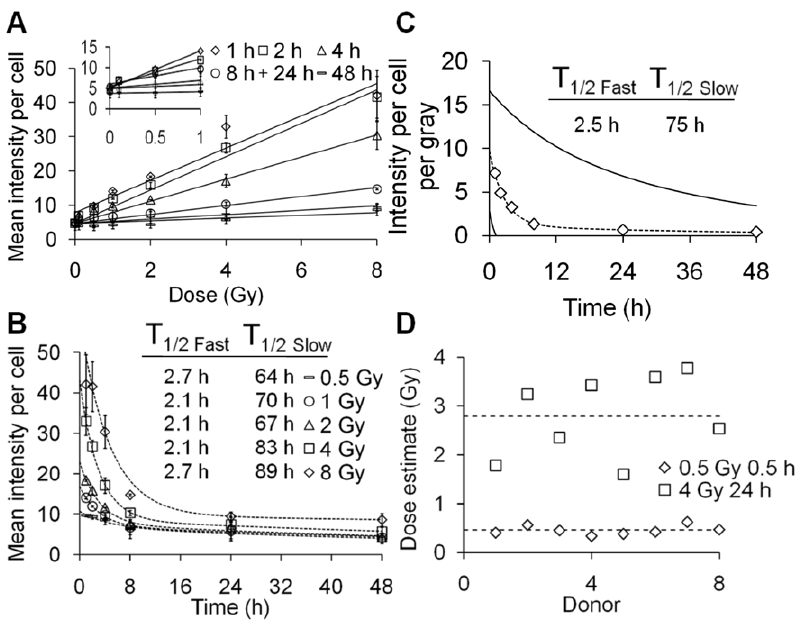
Figure 2. c -H2AX intensity induction and loss after uniform exposure to X-rays, detected by flow cytometry. (A) Mean c -H2AX intensity observed between 1–48 hours post exposure. Linear regressions (lines) were fitted to all data points. (B) c -H2AX intensity loss over 48 hours post exposure. Dashed lines represent bi-exponential fits for c -H2AX loss for each dose. T 1/2 fast and T 1/2 Slow represent the individual half-lives of the two exponentials. (C) c -H2AX intensity yields per cell per gray between 1–48 hours calculated using linear regression coefficients of c -H2AX intensity yields from Figure 2A. The dashed line represents a bi-exponential fit for mean c -H2AX loss per unit dose and solid lines the upper and lower 95% confidence limits. (D) Dose estimates in X-irradiated lymphocytes from 8 healthy donors. c -H2AX intensity was measured and the dose estimated using the calibration curve from Figure 2C.